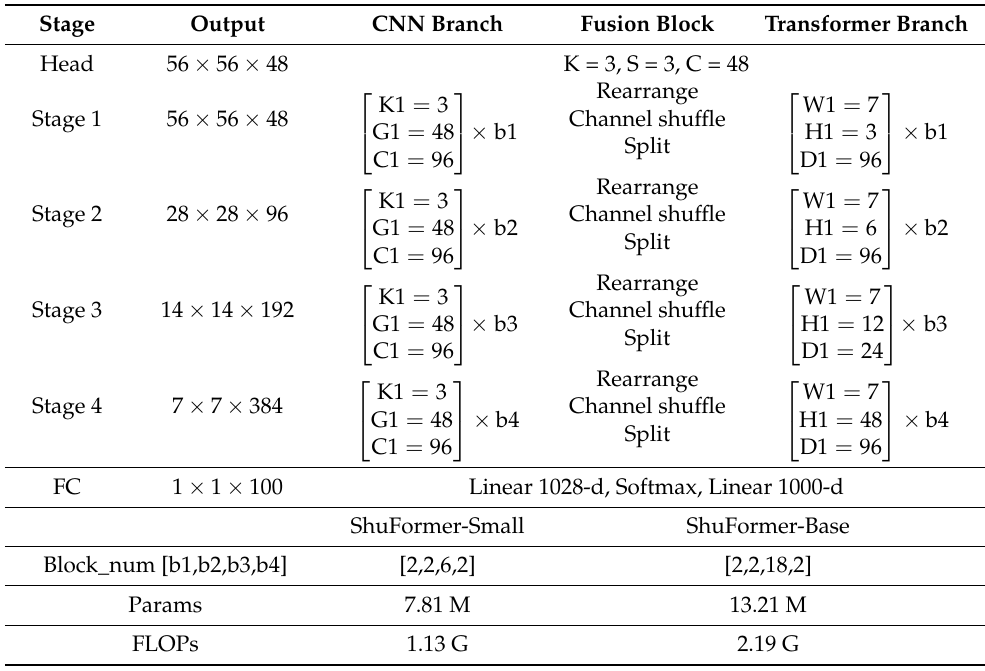
Table 3. Network configurations of ShuFormer (the parameters of building blocks are shown in brackets, with the numbers of blocks